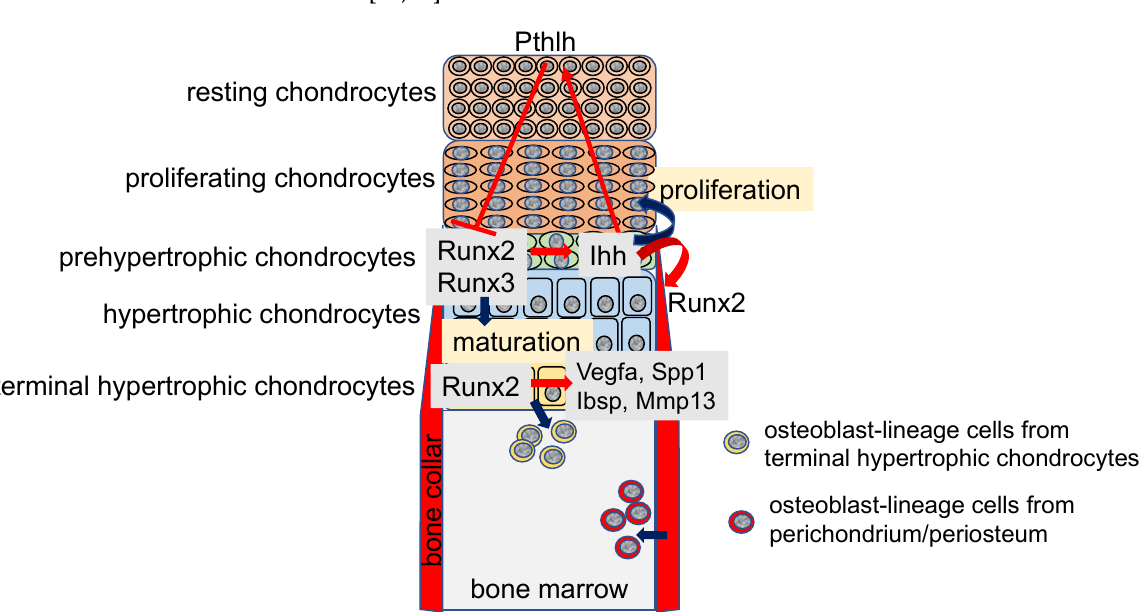
Figure 1. Regulation of chondrocyte maturation and proliferation in the growth plate and osteoblas- togenesis in the bone marrow: Runt-related transcription factor 2 (Runx2) expression is upregulated in prehypertrophic chondrocytes and Runx2 induces chondrocyte maturation. Runx3 is also involved in chondrocyte maturation. Runx2 induces Indian hedgehog (Ihh) expression in the prehypertrophic chondrocytes, and Ihh enhances the proliferation of chondrocytes in the proliferating layer. Ihh also induces the expression of parathyroid hormone like hormone (Pthlh), which inhibits Runx2 expression through parathyroid hormone 1 receptor (Pth1r), and inhibits chondrocyte maturation, forming a negative feedback loop of chondrocyte maturation. Ihh induces Runx2 expression and osteoblast differentiation in the perichondrium. Runx2 induces the expressions of vascular endothelial growth factor A (Vegfa), secreted phosphoprotein 1 (Spp1), integrin binding sialoprotein (Ibsp), and matrix metallopeptidase 13 (Mmp13) in the terminal hypertrophic chondrocytes. Runx2 inhibits the apoptosis of terminal hypertrophic chondrocytes and induces the transdifferentiation of the terminal hypertrophic chondrocytes into osteoblast lineage cells. Osteoblasts in the bone marrow are derived from chondrocytes in the growth plate and osteoblast progenitors in the perichondrium/periosteum. Runx3 is expressed in prehypertrophic and hypertrophic chondrocytes, and chondrocyte maturation is slightly delayed in Runx3 − / − embryos. Furthermore, Runx2 − / − Runx3 − /